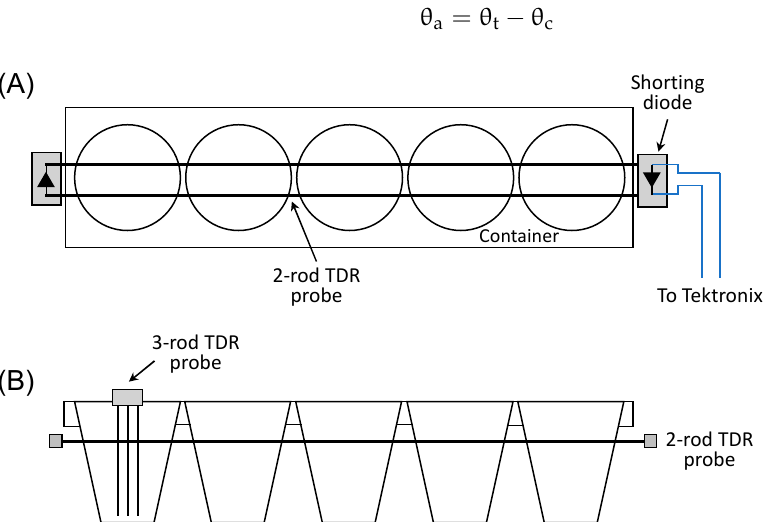
Figure 2. Schematic of the linear five-cavity container (aerial ( A ) and lateral ( B ) views) including a 10.5 cm long three-rod TDR probe inserted vertically within a cavity and a 36 cm long two-rod TDR probe with shorting diodes inserted horizontally across the five cavities at a height of 8 cm from the bottom of the container.